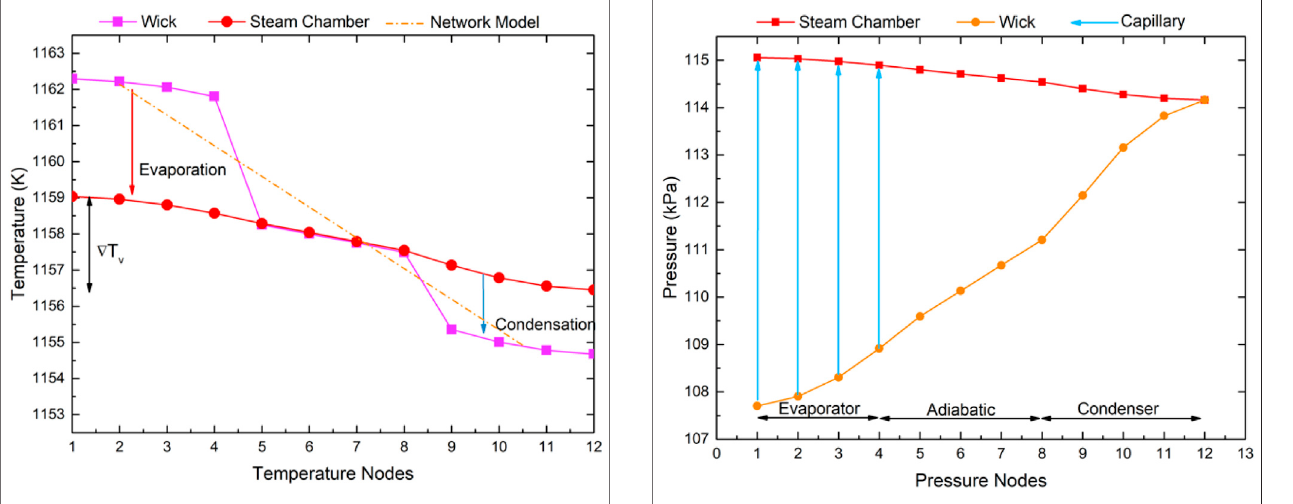
FIGURE 17 | Mass fl ow rate in the vapor